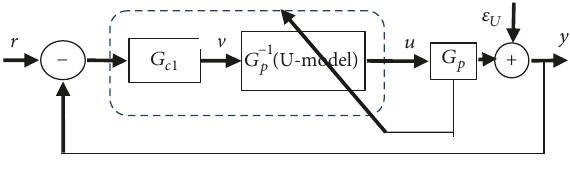
Figure 3: Uncertain U-model control